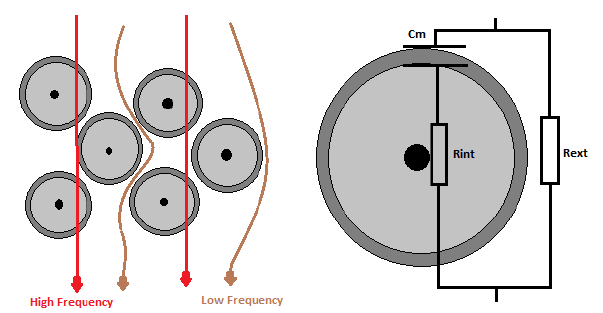
Figure 7: Paths of high and low frequency currents in a biological